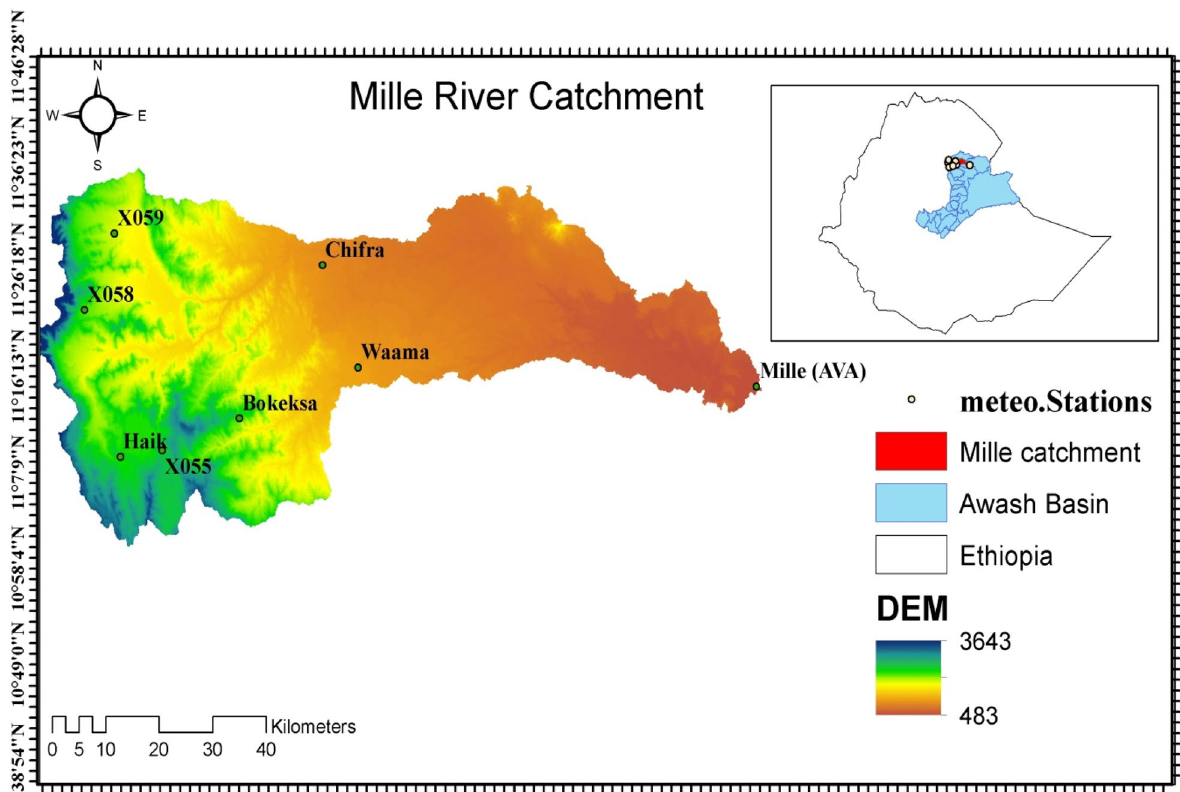
Fig. 1 Study area, Mille catchment